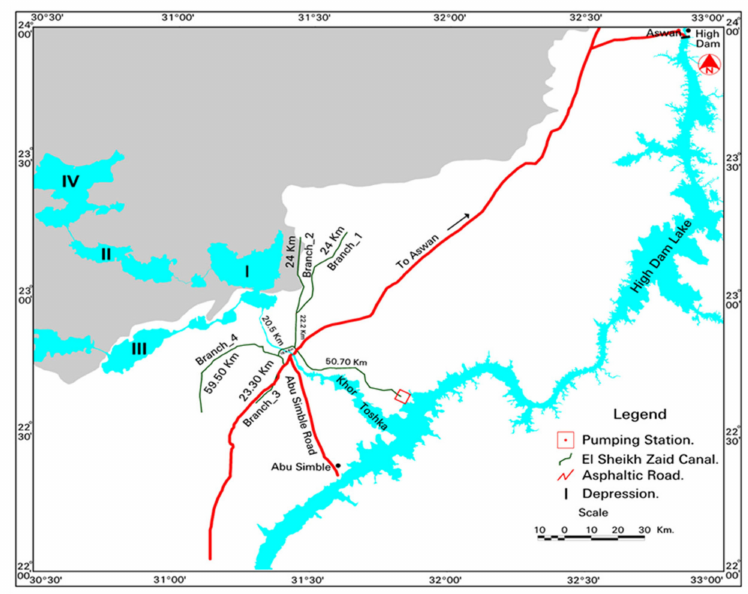
Figure 1. Location of Sheikh Zayed canal, its branches, and the pumping station on Lake Nasser in Upper Egypt